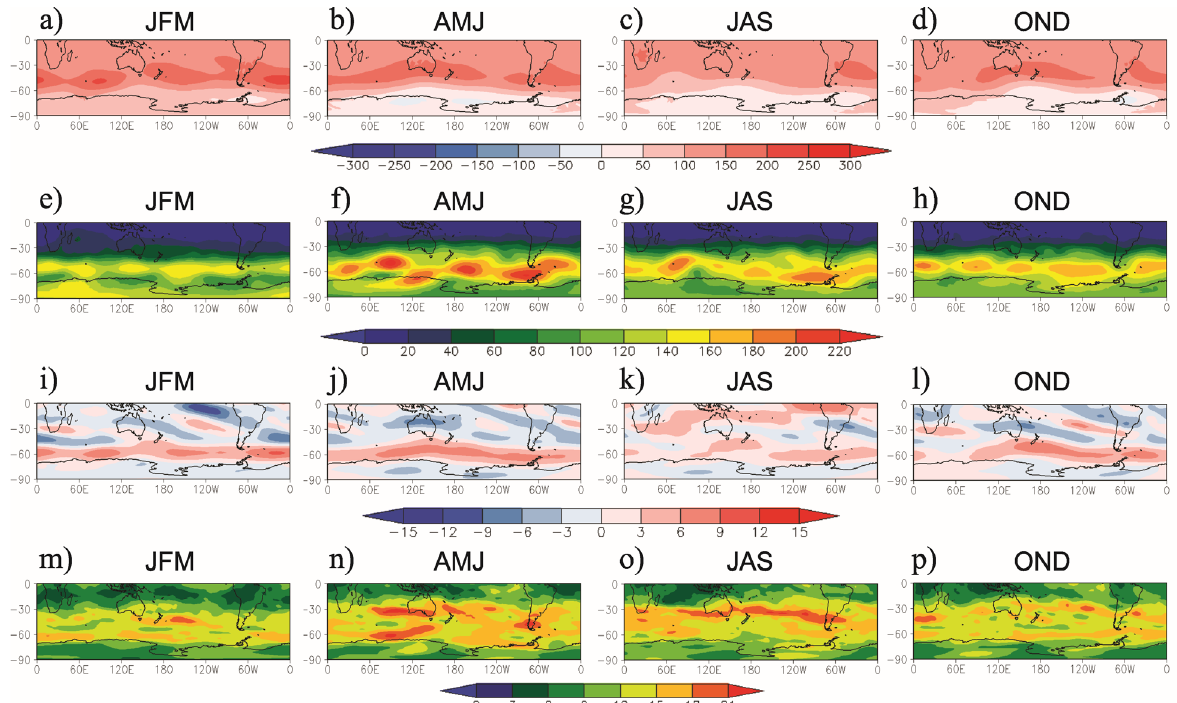
Figure 5. Seasonal difference of (a, b, c, d) 500-hPa geopotential height (m) and (i, j, k, l) 250-hPa zonal wind (ms -1 ) between the CCSM4 historical experiment and the ERA-Interim reanalysis and standard deviation of (e, f, g, h) 500- hPa geopotential height (m) and (m, n, o, p) 250-hPa zonal wind (ms -1 ) from the CCSM4 historical experiment during summer (JFM; first column), autumn (AMJ; second column), winter (JAS; third column) and spring (OND; fourth column) over